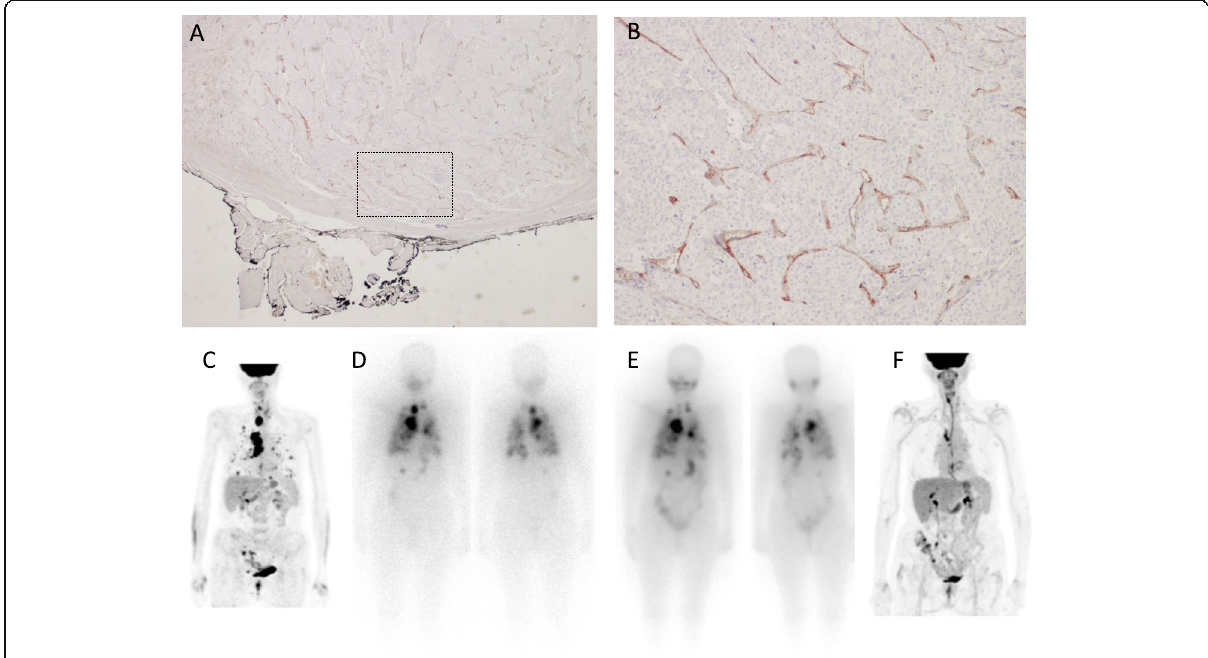
Fig. 4 Example of PSMA staining in an 80-year-old female diagnosed with a poorly differentiated thyroid cancer (presence of vascular invasion, free surgical margins, pT3mpN1acM1 – stage IVb). Panoramic view ( a , × 2) shows the insular pattern of growth highlighted by PSMA staining which involves endothelial cells almost completely ( b , × 20) and was quantified as 80%. Staging PET/CT image ( c ) shows [ 18 F]FDG uptake in the left lobe of thyroid, cervical, and mediastinal lymph nodes, lungs, and liver. Diagnostic whole-body scan (185 MBq) obtained 3 months after thyroidectomy shows several foci of radioiodine (RAI) uptake in the mediastinum, lungs, and liver ( d ). Images ( e ) obtained after RAI treatment (5550 MBq) show uptake in mediastinum, lungs (fewer lesions than on the diagnostic scan), and liver. Accordingly, the patient was defined as RAI